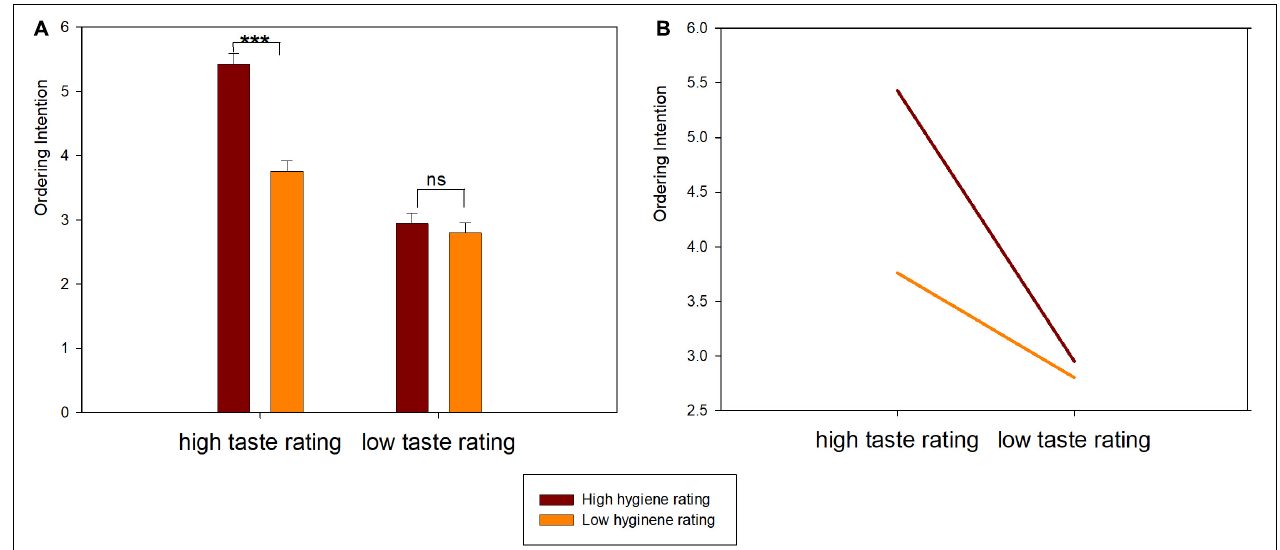
FIGURE 1 | Ordering intention results in Study 1. (A) Bar graph. (B) Linear graph. *** p < 0.001, ns p >